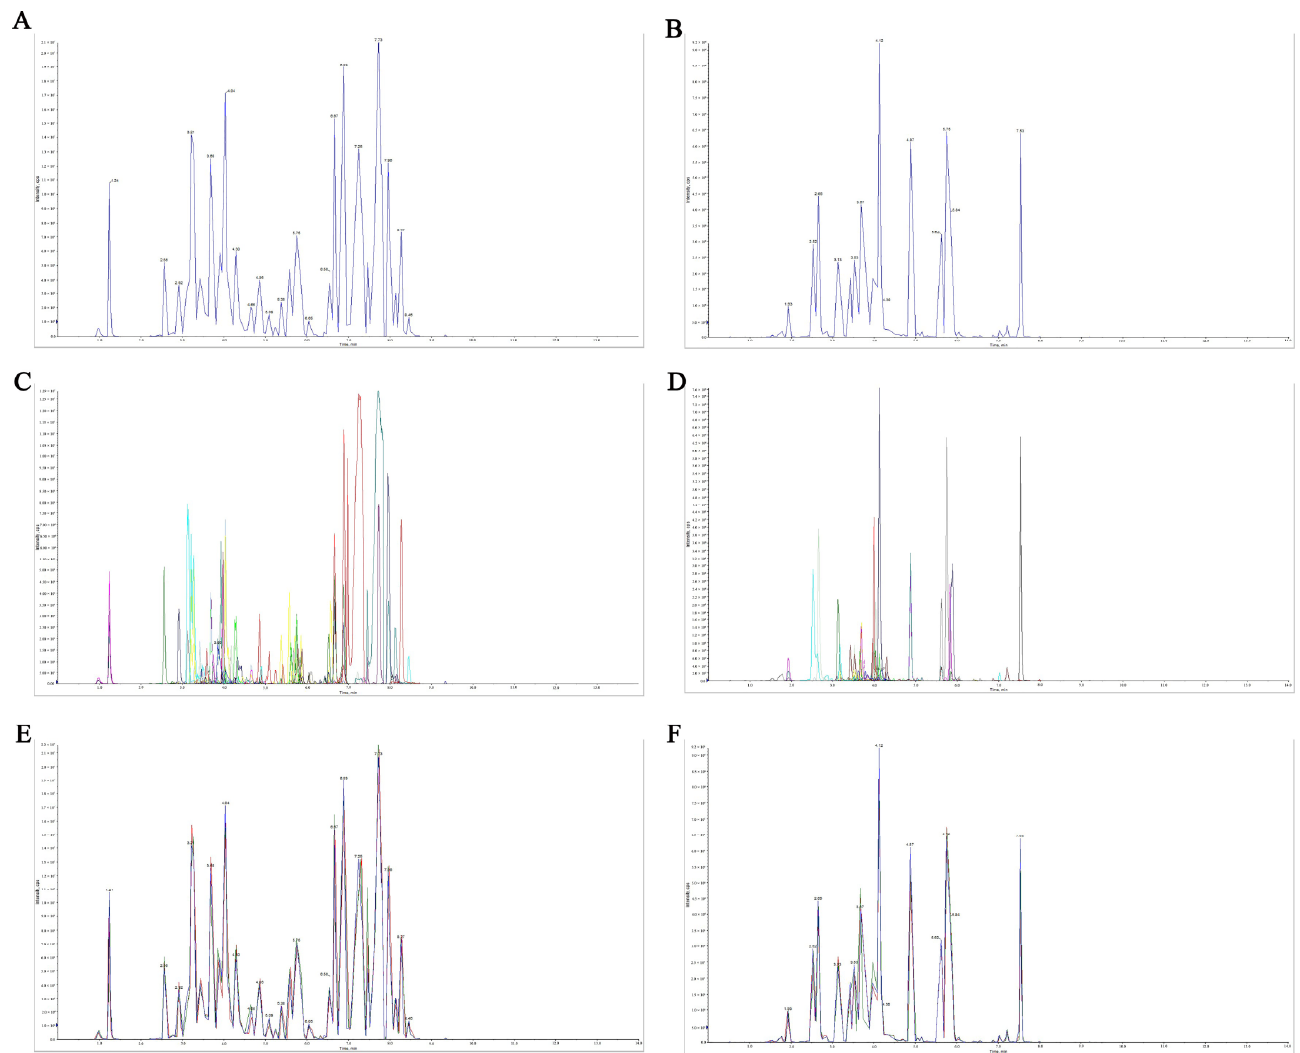
Figure 3. TIC diagram of QC sample mass spectrometry detection, multi-peak diagram of MRM metabolite detection and TIC superimposition diagram. ( A , B ) are the total positive ion current and total negative ion current diagrams detected by mass spectrometry of QC samples, respectively.